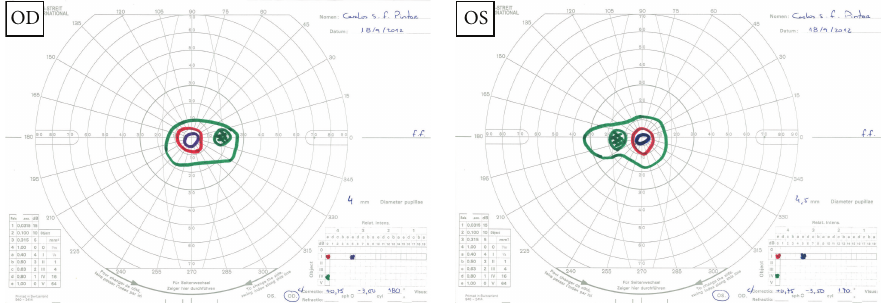
Figure 5: Goldmann kinetic perimetry: tubular visual field.